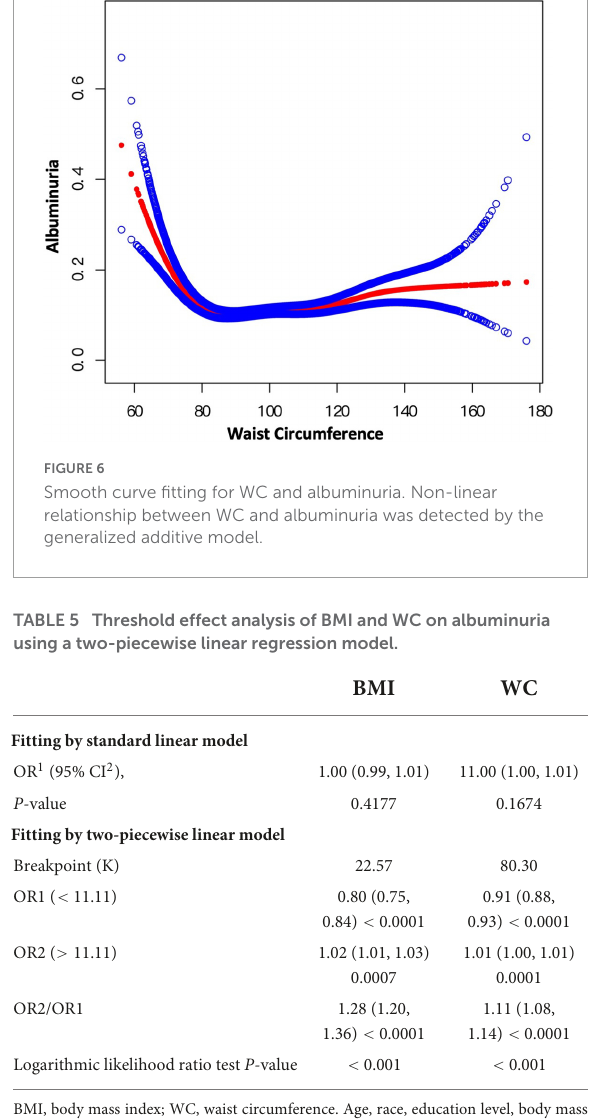
TABLE 4 Threshold effect analysis of WWI on albuminuria using a two-piecewise linear regression model.